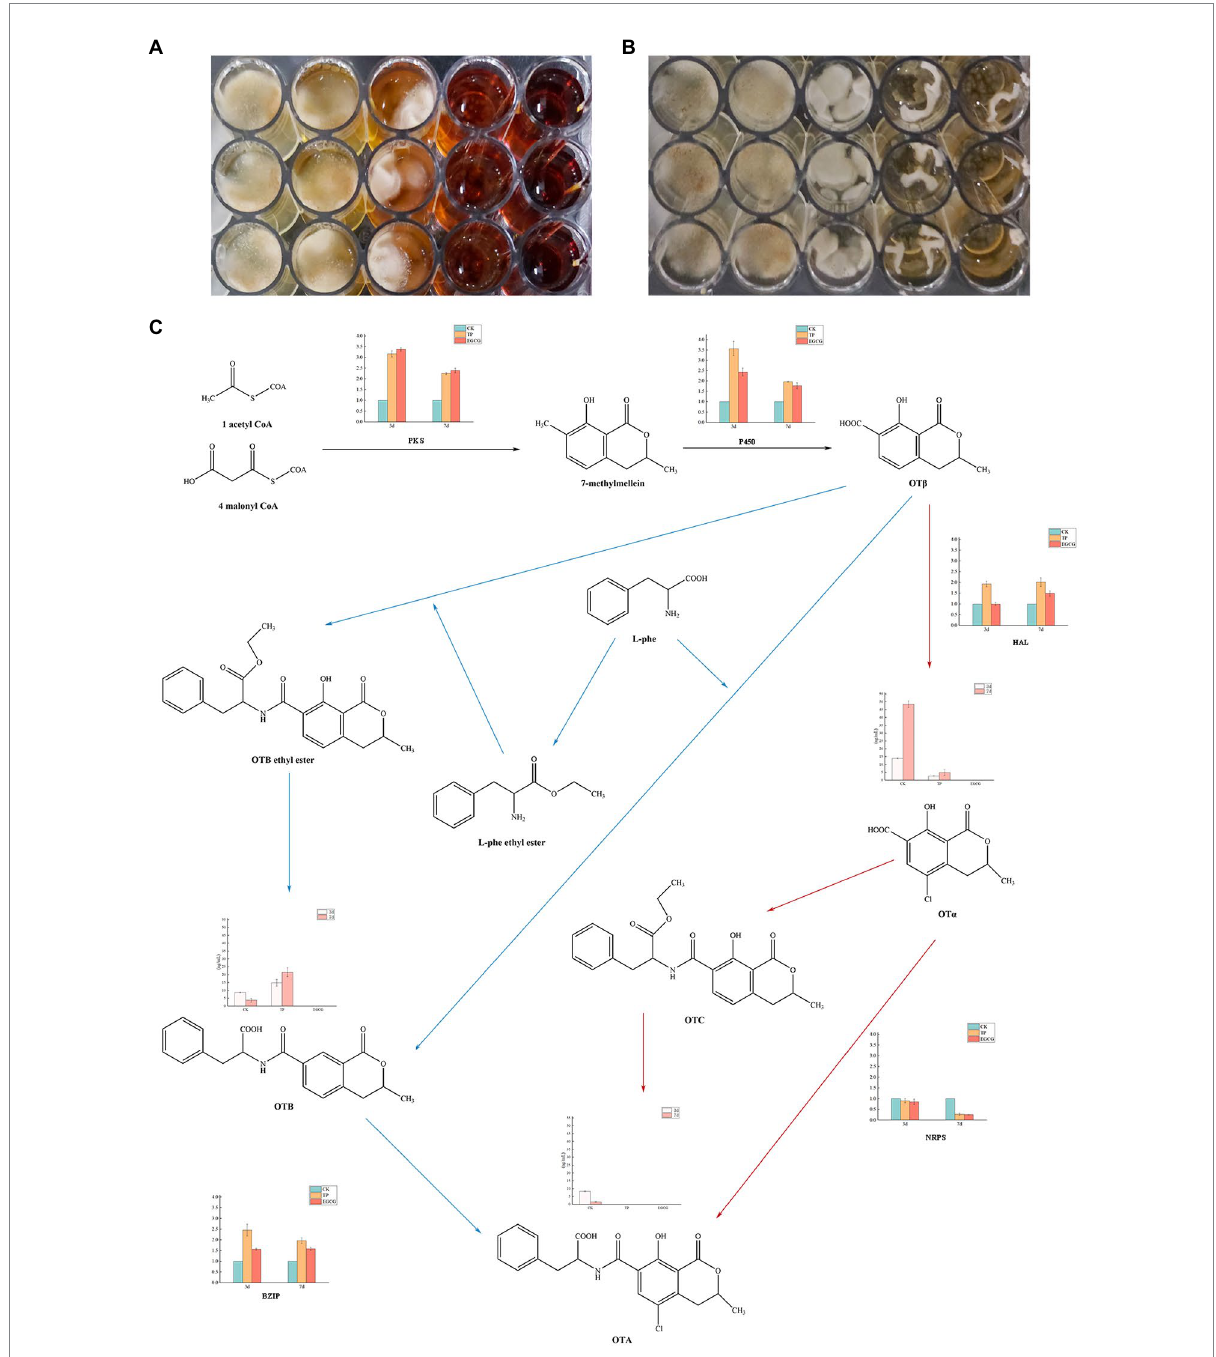
FIGURE 3 Inhibitory effects of TPs and EGCG on Aspergillus niger . (A) Growth of A. niger AN3 in medium containing TPs. (B) Growth of A. niger AN3 in medium containing EGCG. (C) OTA synthesis pathway and expression of OTA synthesis-related genes and concentrations of OT α , OTA, and OTB in A. niger AN3 ( BZIP , a pathway-specific regulator that controls OTA production by regulating the PKS , P450 , HAL , and NRPS